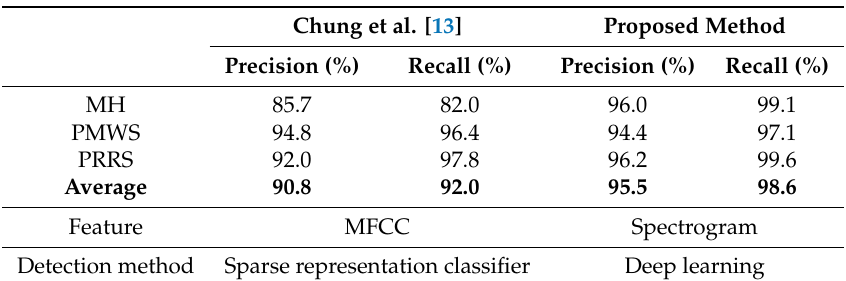
Table 8. Comparison of respiratory disease identification performance between proposed method and that used by Chung et al.